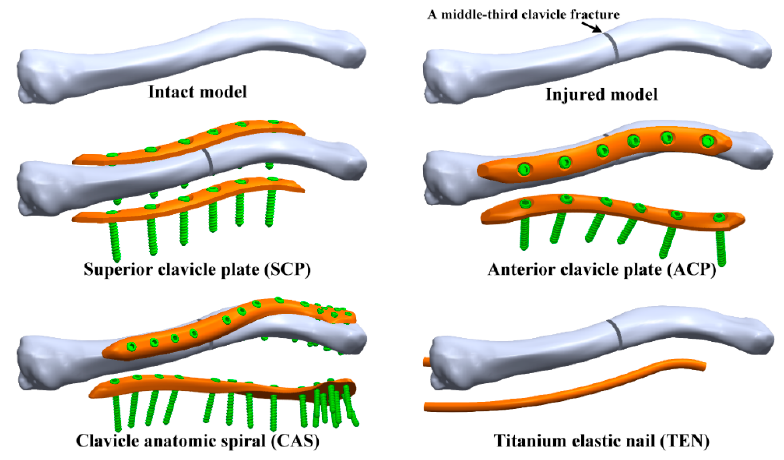
Figure 1. Simplified single ‐ clavicle models.